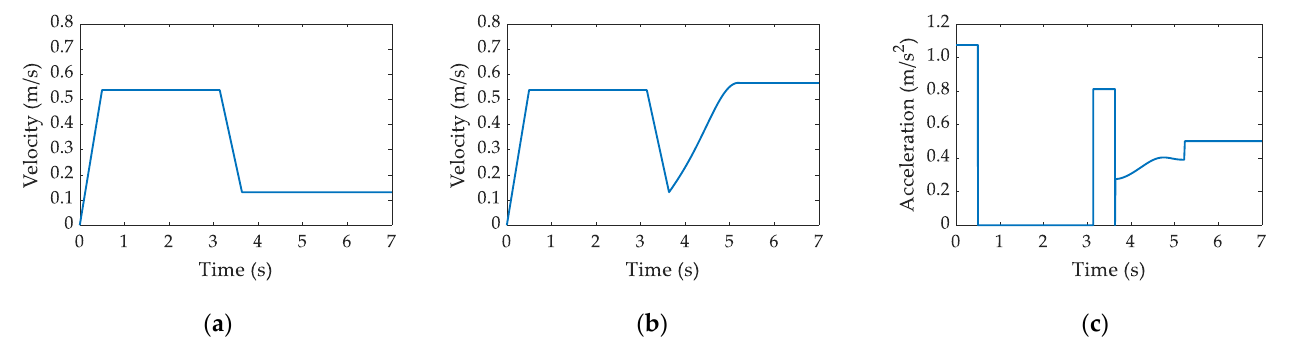
Figure 8. ( a ) Preset linear velocity of the chain system; ( b ) velocity of the point 𝑃 cm ; ( c ) acceleration of the point 𝑃 cm . According to the dynamic equations, the driving force required for the motion of the manipulator and the normal force of the manipulator acting on the track are shown in Figure 9. It can be seen that when the manipulator enters the circular arc section of the track, the driving force and the normal force increase significantly. In the lifting motion, the driving force required by the manipulator is the largest when accelerating.